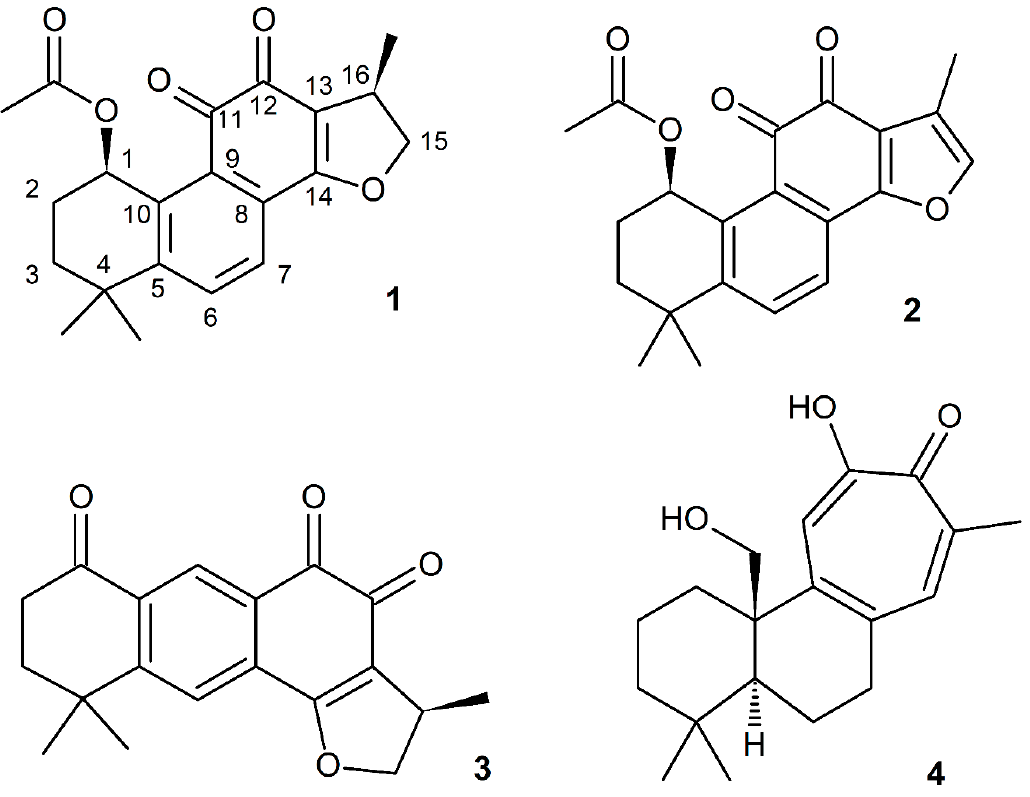
Figure 1. Structures of compounds 1–4 isolated from roots of Perovskia atriplicifolia.